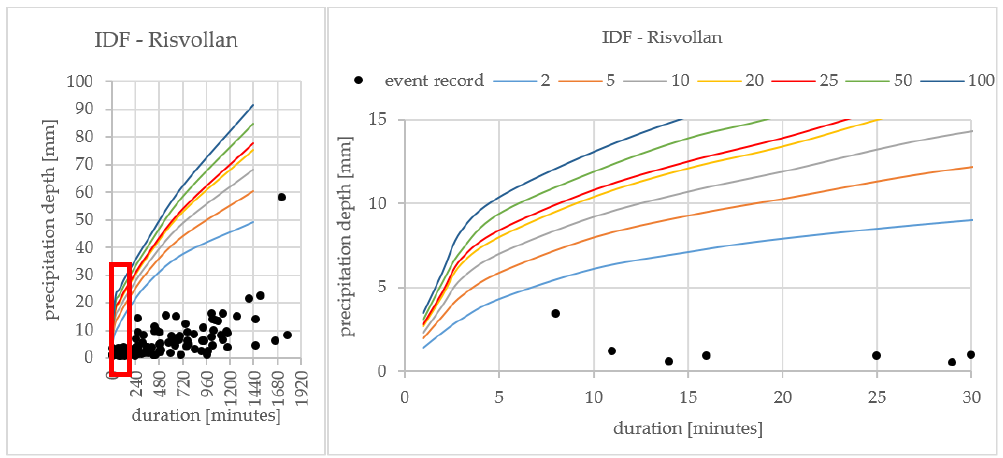
Figure 2. ( left ) The event record comparison with Risvollan Intensity–Duration–Frequency (IDF) curves for different return periods; ( right ) 30-min resolution.